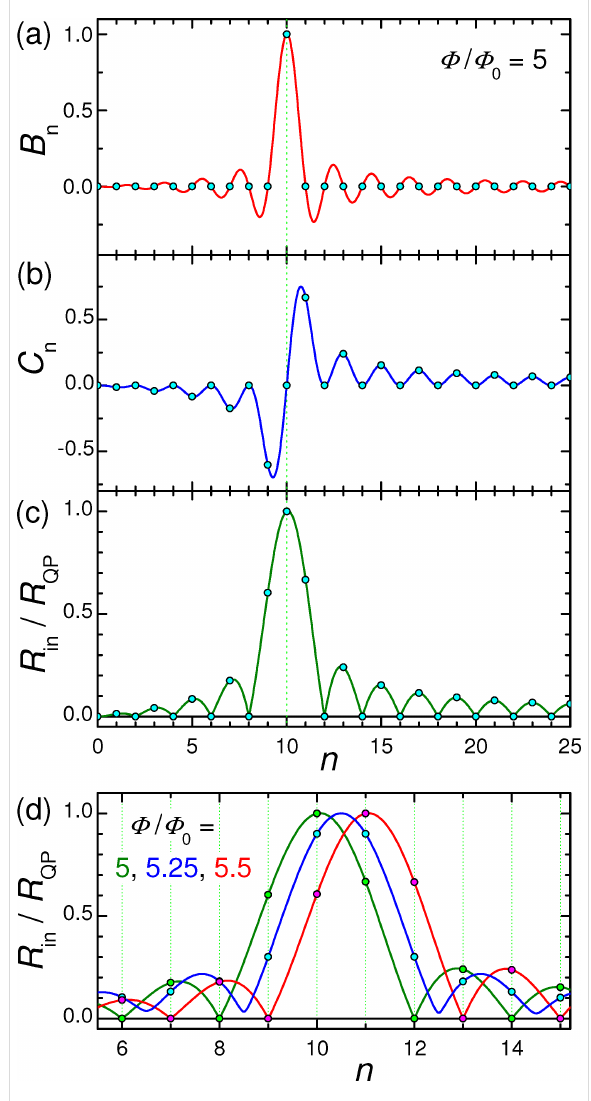
Figure 3: Panels (a) and (b) show mode-number dependence of coef- ficients B n and C n , given by Equation 20 and Equation 21, for the case from Figure 2 with Φ / Φ 0 = 5. Panel (c) shows the corresponding oscil- latory dependence of the input resistance, Equation 28 and Equation 33. (d) Input resistance for Φ / Φ 0 = 5 (olive), 5.25 (blue) and 5.5 (red). The large R in enables good coupling of the cavity mode to the Josephson